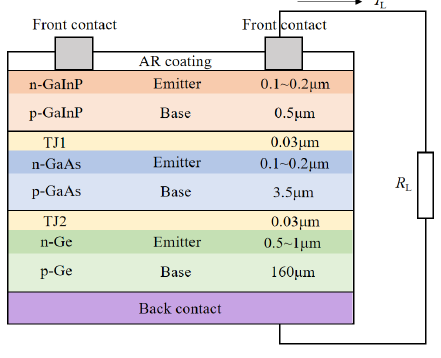
Figure 7. GaAs cells mounted on the UAV.